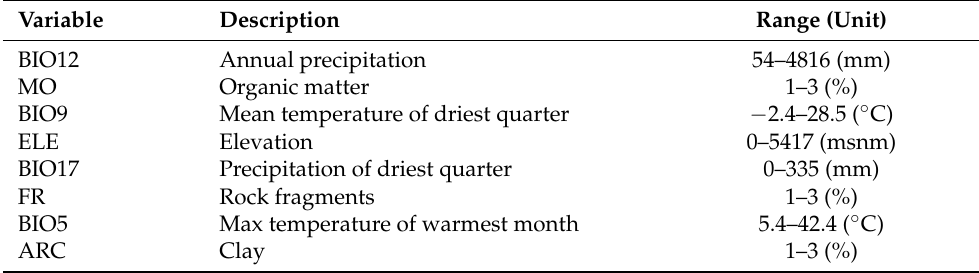
Table 1. Variables used in ecological niche modeling in MaxEnt.